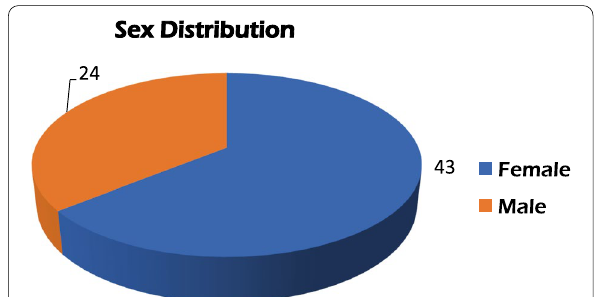
Fig. 2 Pie diagram showing sex distribution of NVC